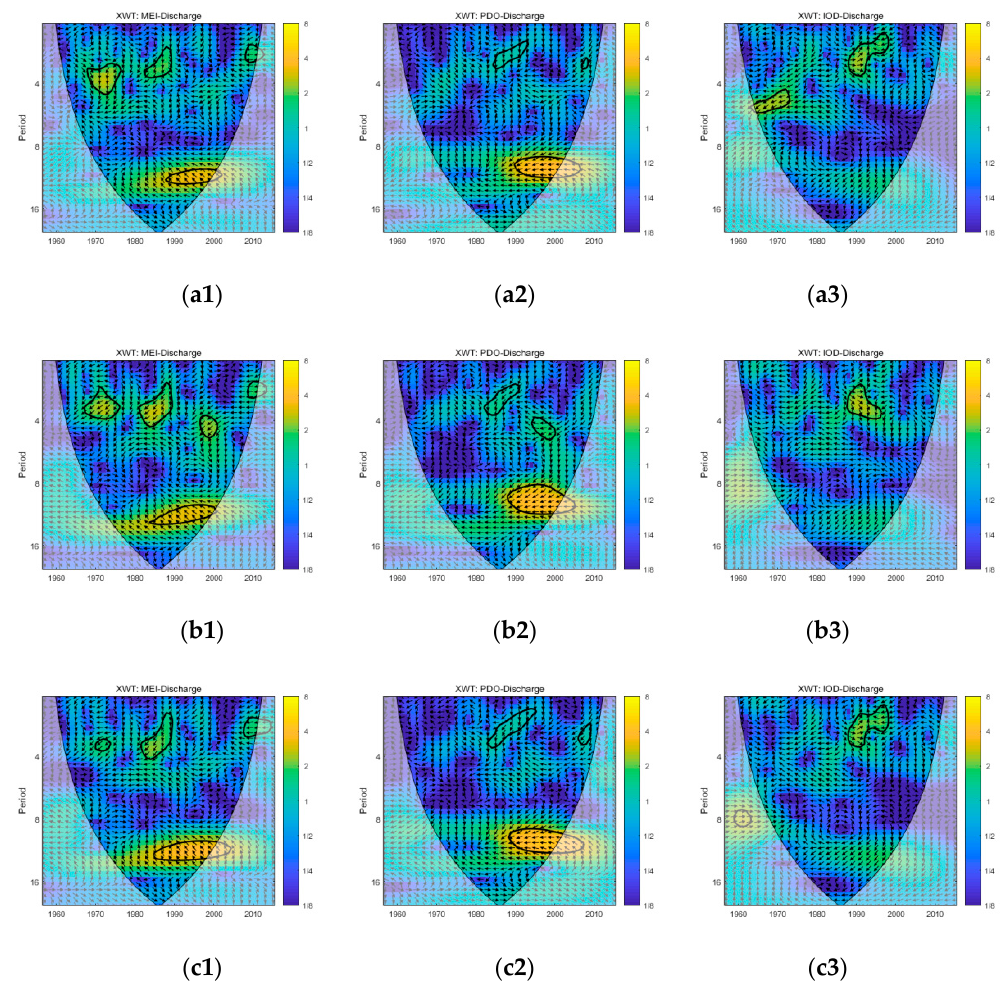
Figure 13. Cross wavelet transform of discharge of three hydrological stations with MEI, PDO, and IOD, respectively. (( a1 – a3 ) Nuxia station; ( b1 – b3 ) nugesha station; ( c1 – c3 ) yangcun station). The meaning in the figure is the same as in Figure 10.